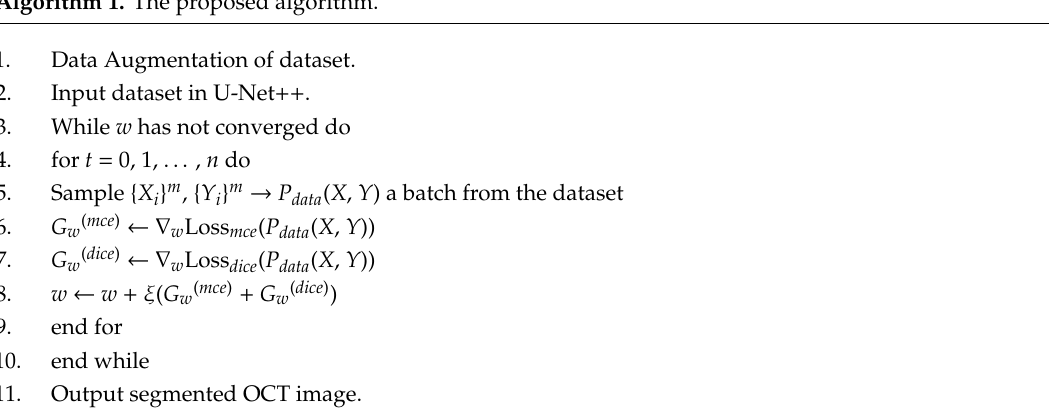
Algorithm 1. The proposed